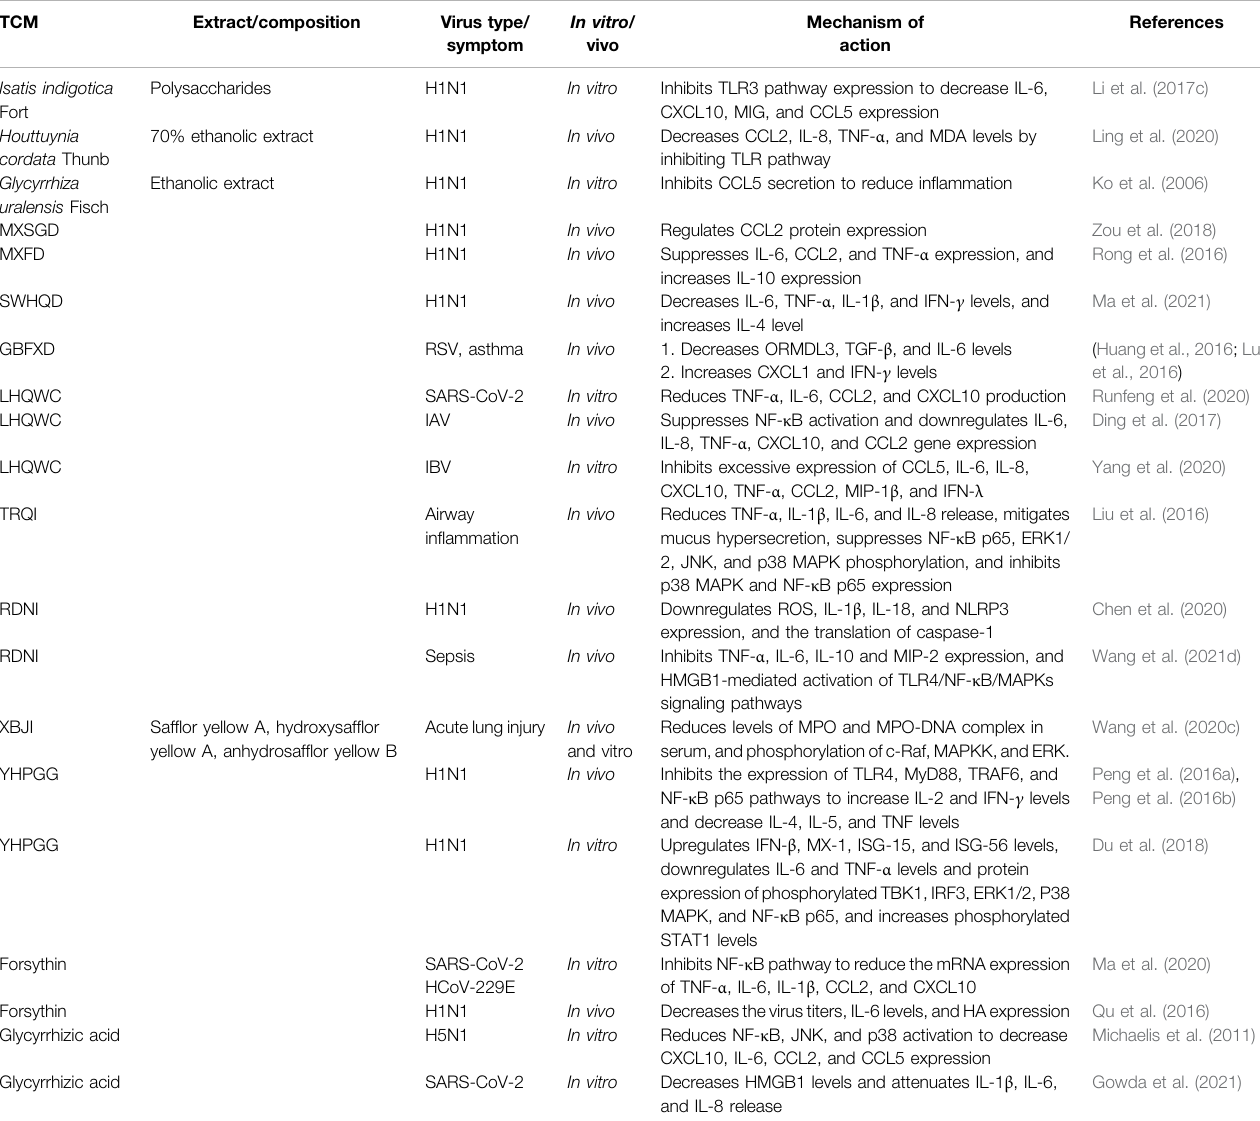
TABLE 4 | TCMs that control in fl ammatory